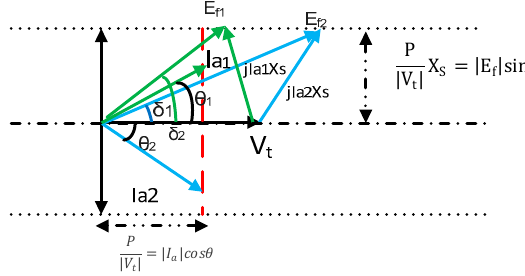
Figure 3. The terminal voltage and injected reactive power of the PV bus with respect to network demand.